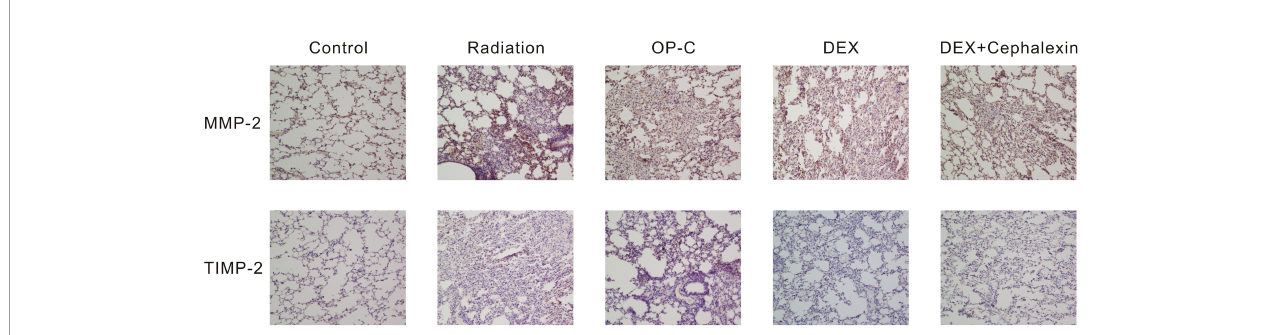
FIGURE 5 | Effects of Ophiopogonin C (OP-C) on the expression of MMP-2 and TIMP-2 changes in the lung tissue at 28 weeks after whole thoracic irradiation. Photomicrographs show staining of mouse lung tissue sections with MMP-2 and TIMP-2 detected by immunohistochemical staining in mice from the blank control, radiation-only, OP-C, dexamethasone (DEX), and DEX +